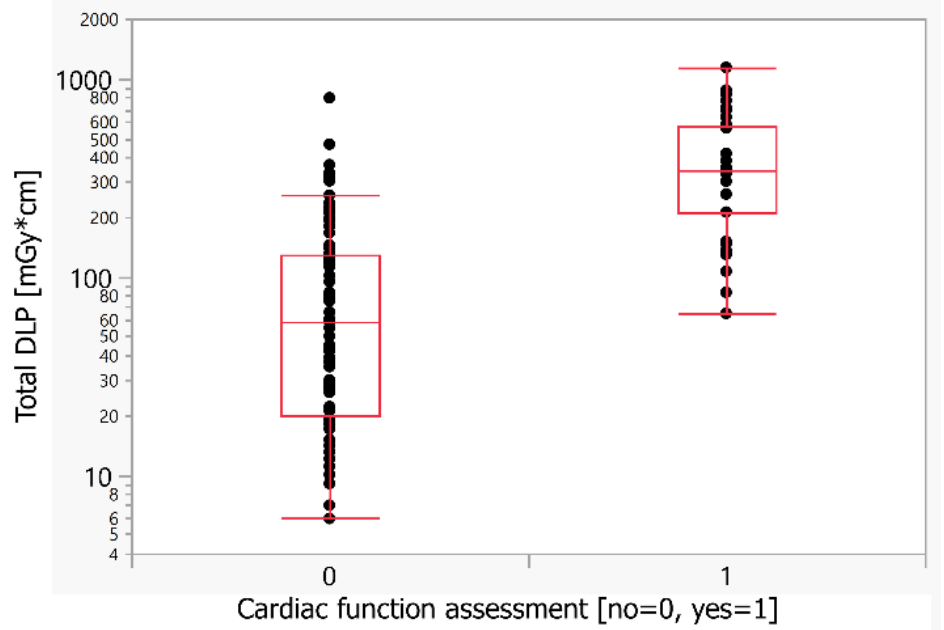
Figure 3. Comparison of the radiation dose for the cardiac function assessment, limited to patients aged > 8.1 y.o. to exclude selection bias due to patient age. DLP—dose-length product (mGy*cm).